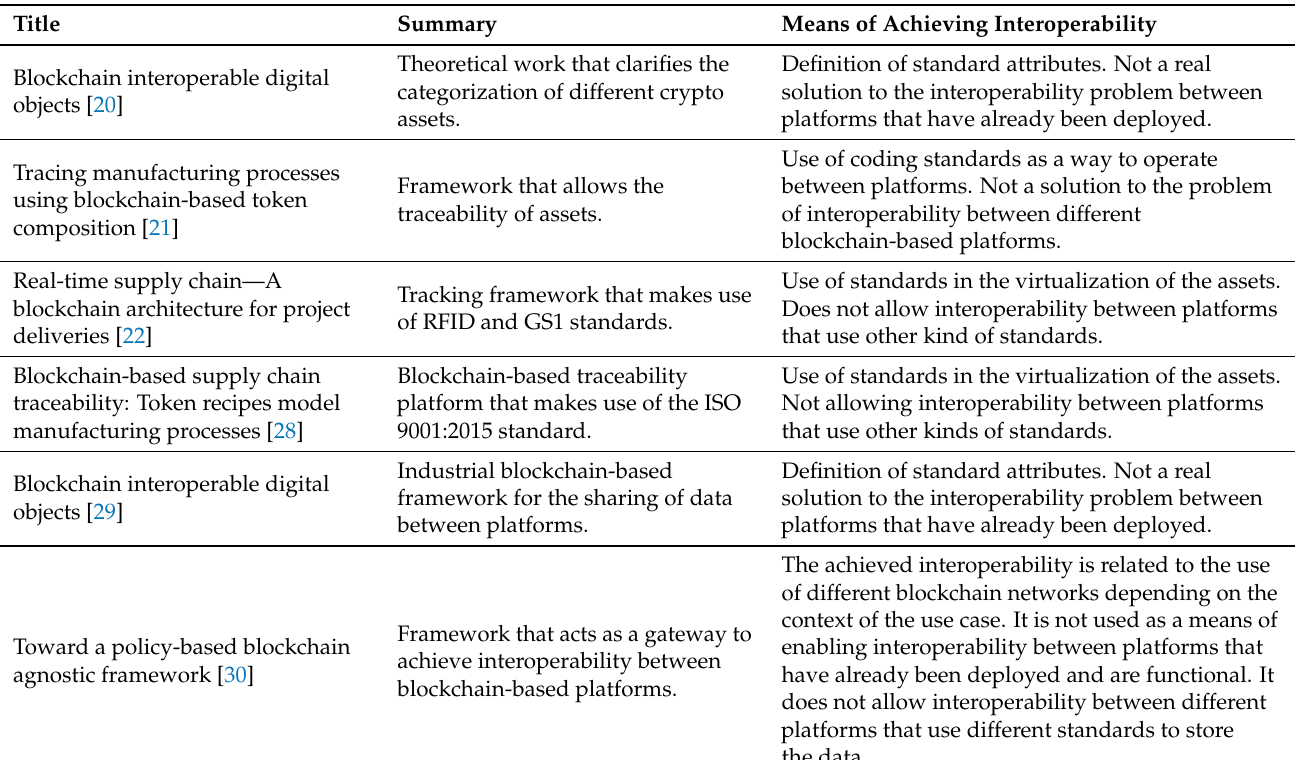
Table 1. Comparative survey of the relevant literature that had been